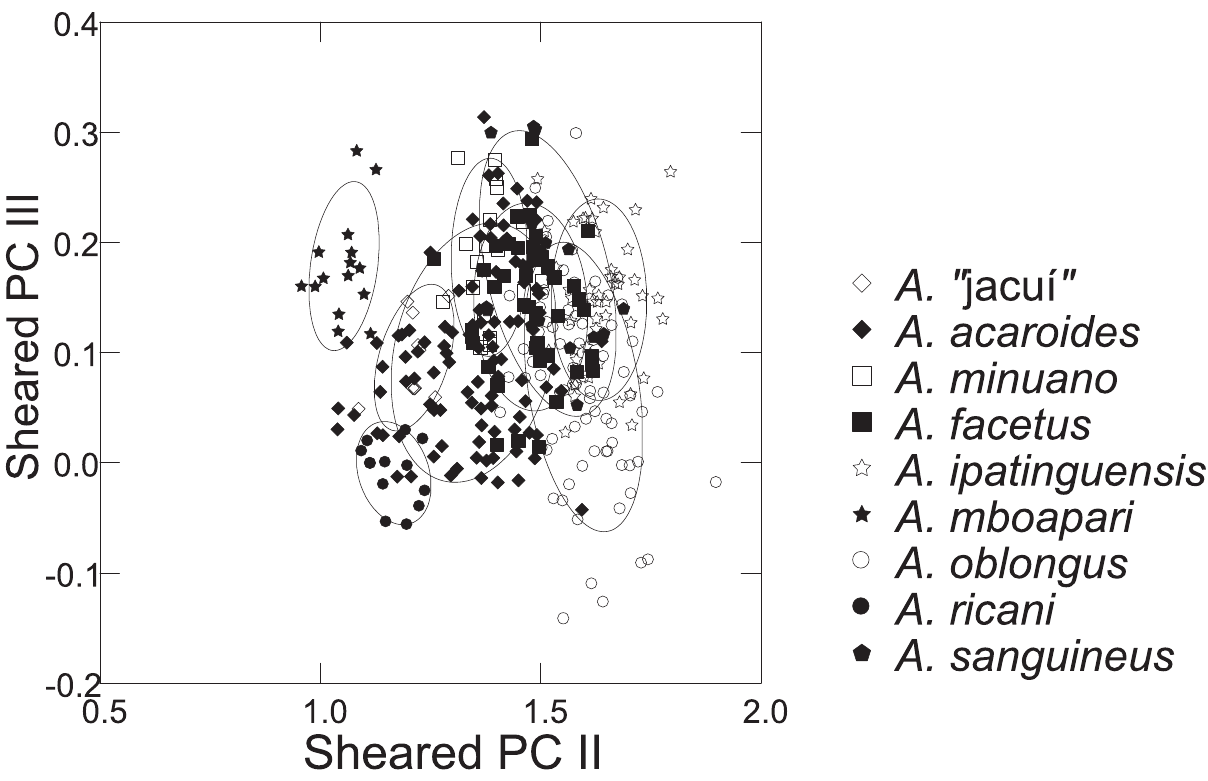
Fig 5. Plot of scores of PC II on PC III from PCA of 13 distance measurements from pooled coastal species of Australoheros , and A . “Jacuı´.” (Table S4.2 in S4 File).